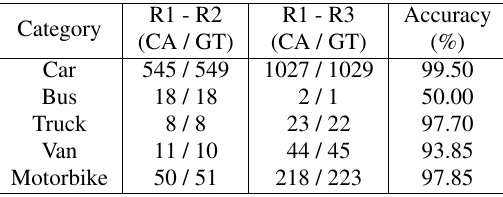
Table 2. The framework results of scenario 1.